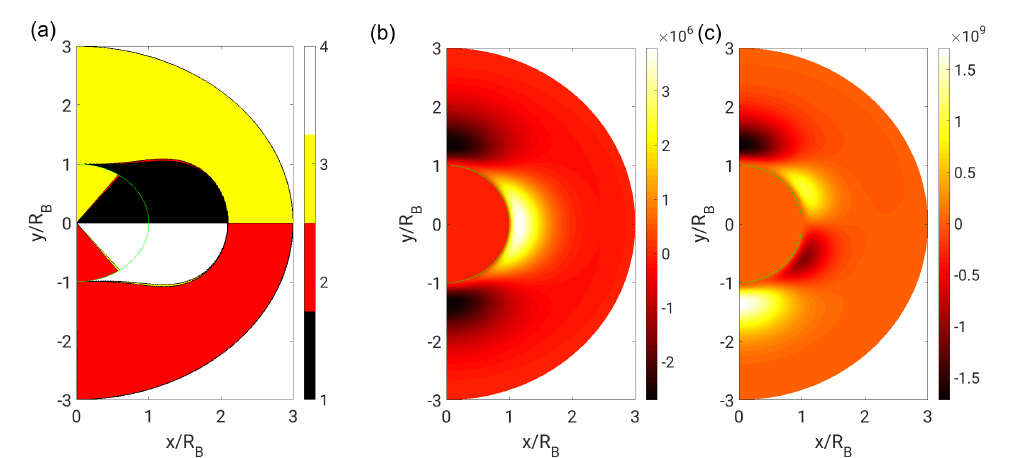
Figure 10. ( a ) Flow topologies; ( b ) second invariant Q ; and ( c ) third invariant R in the droplet case ( ξ = 54.9583) with near-field boundary conditions ( r W = 3 r B ).